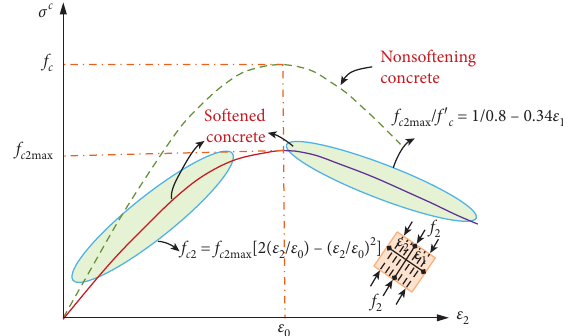
Nonsoftening concrete